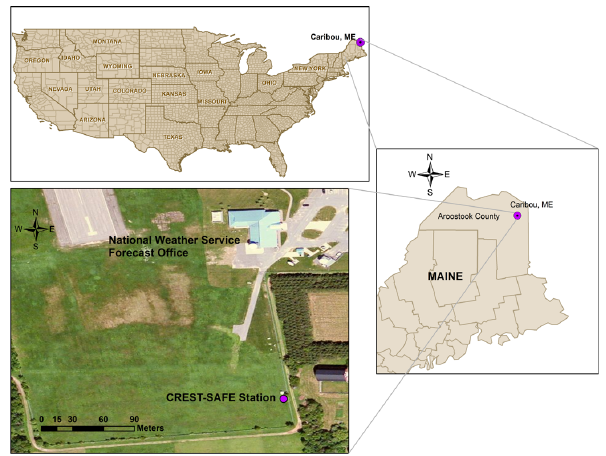
Fig. 1. CREST-SAFE location, near National Weather Service and Caribou Municipal Airport in Caribou, Maine.